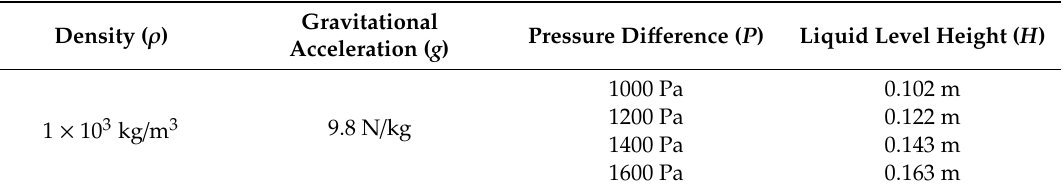
Table 3. The relationship between pressure difference and liquid level.